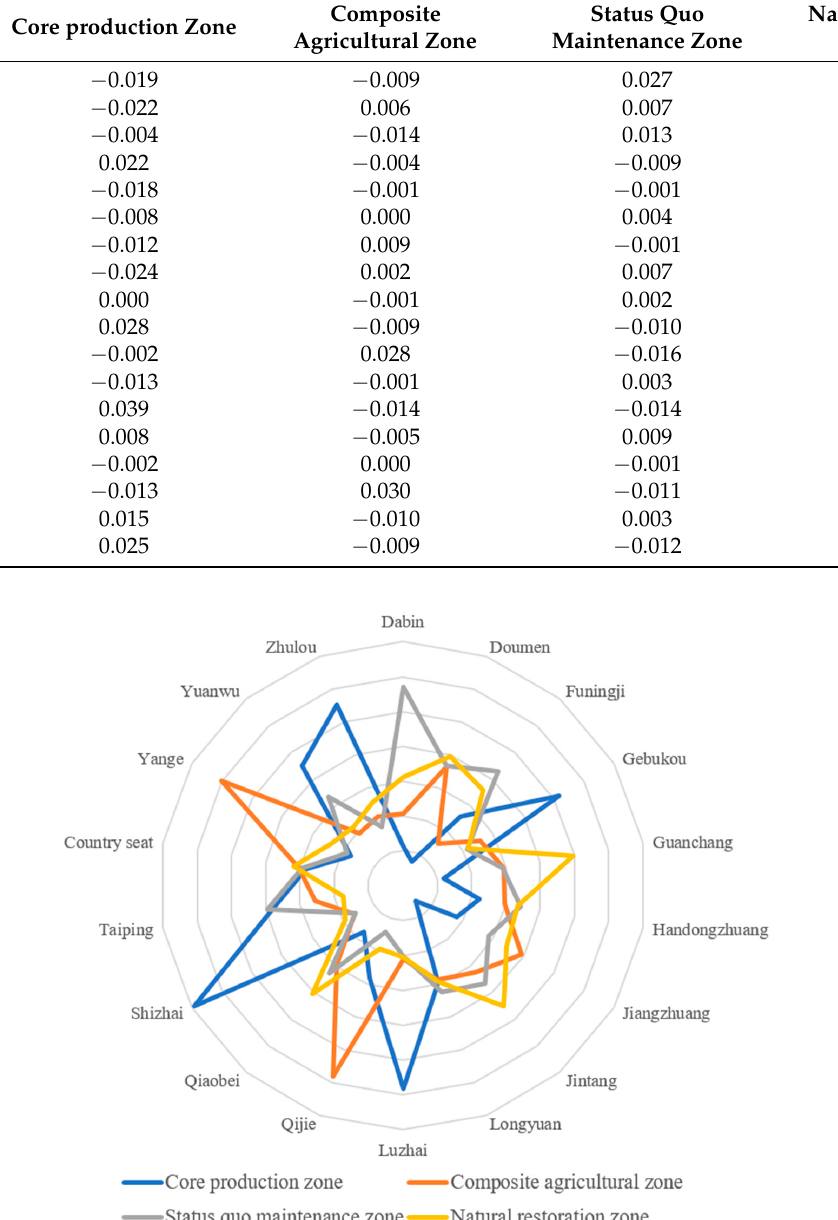
Figure 8. Zoning map for the adjustment of cultivated land use in Yuanyang County: ( a ) before the adjustment; ( b ) after the adjustment. The adjusted cultivated land use zoning achieved the effect of spatial clustering, which is not only convenient for implementation and management but can also achieve scale benefits to a certain extent.